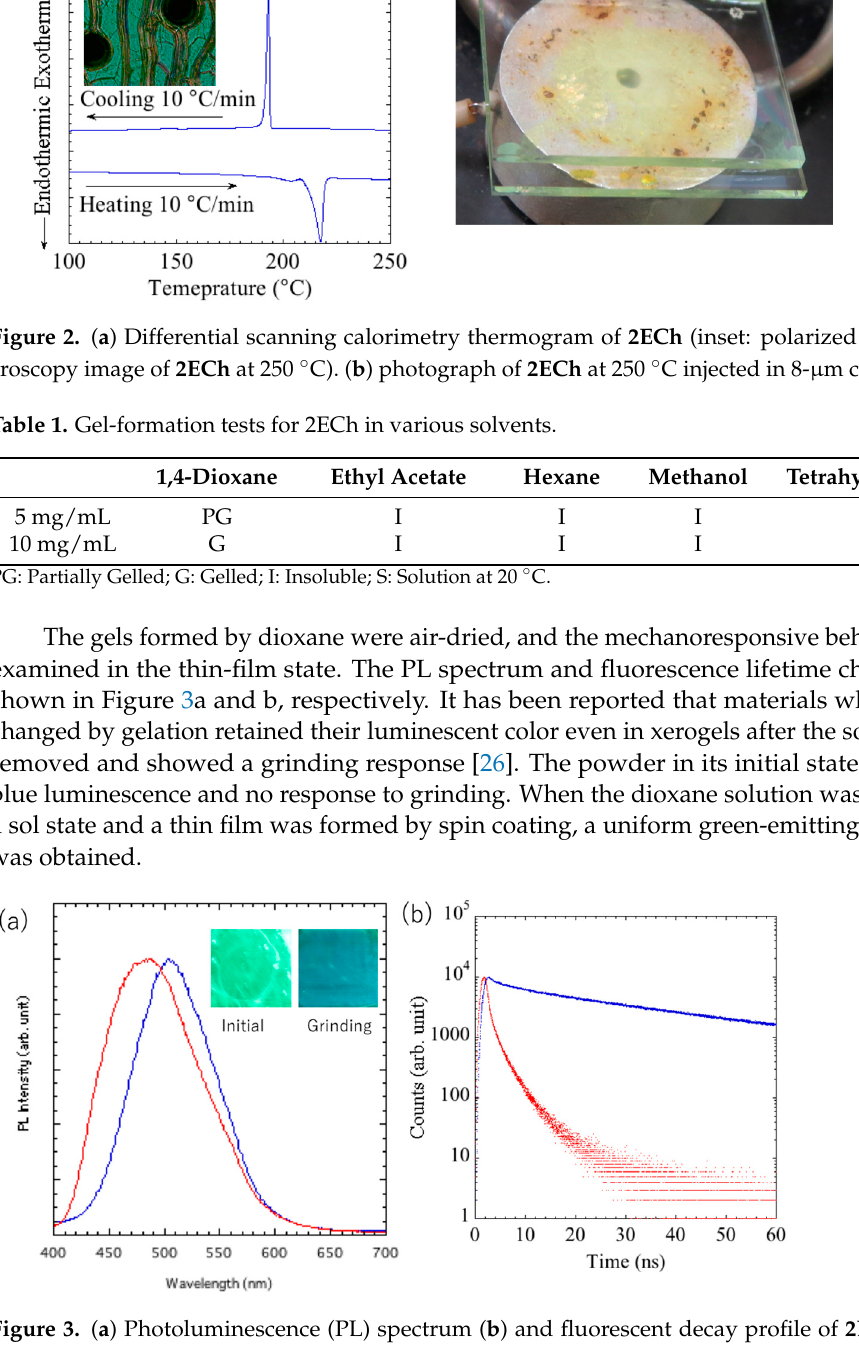
Figure 3. ( a ) Photoluminescence (PL) spectrum ( b ) and fluorescent decay profile of 2ECh before (blue) and after (red) mechanical grinding. The inset in ( a ) displays PL color of 2ECh .